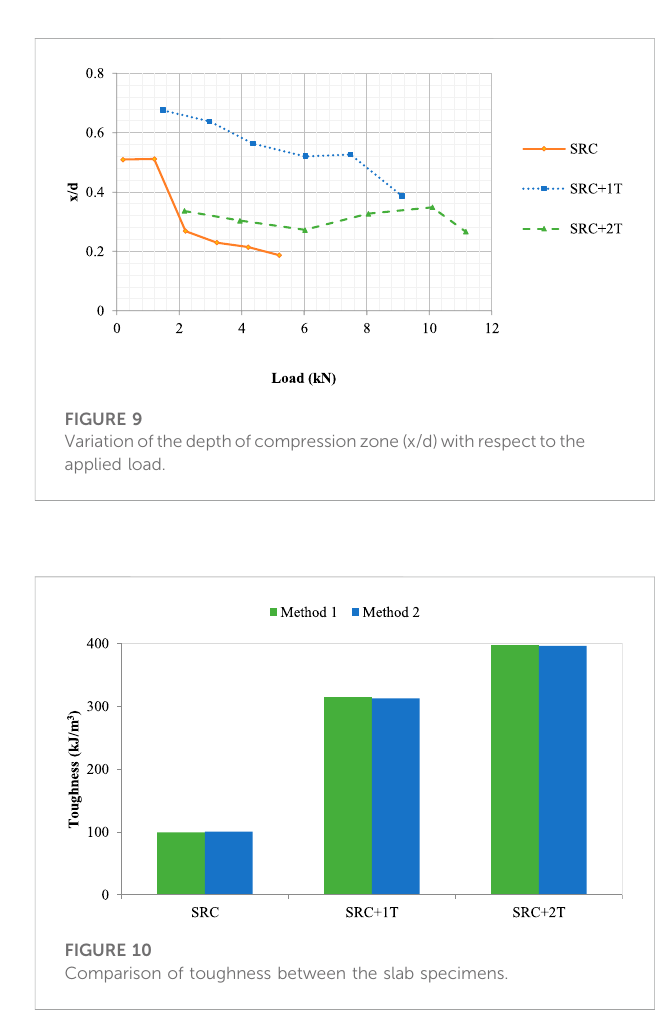
FIGURE 10 Comparison of toughness between the slab